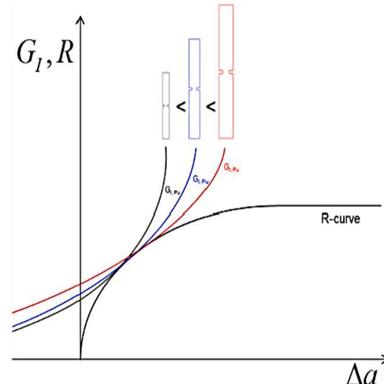
R-curve as an envelope of peak load driving force curves for geometrically scaled specimens.